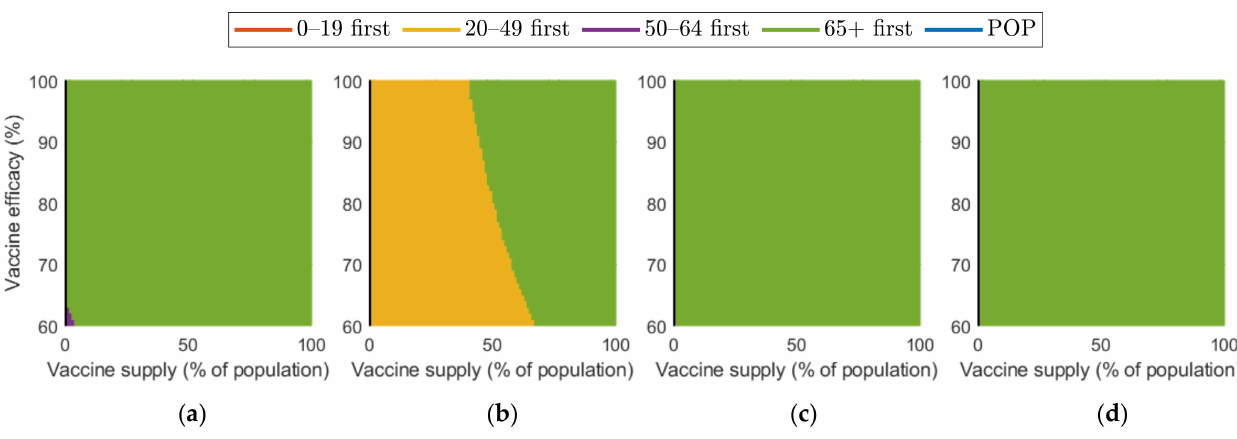
Figure 11. Effect of vaccination supply and efficacy on the reduction in mortality for different SD levels: ( a ) 0, ( b ) 1, ( c ) 2, and ( d )